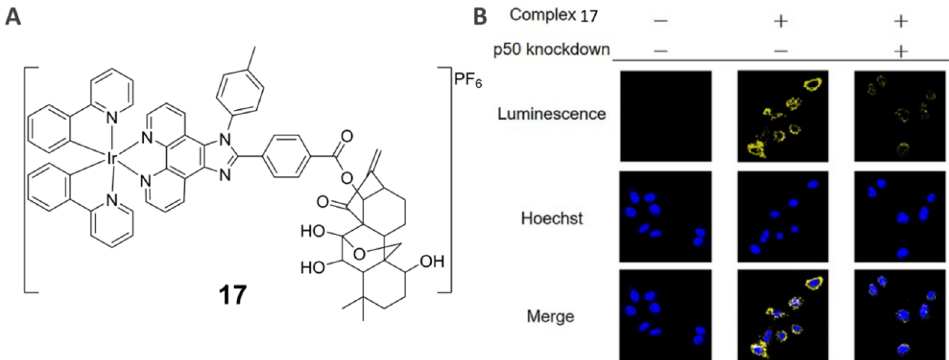
Figure 12. ( A ) Chemical structure of complex 17 . ( B ) Effects of p50 knockdown on the tracking of NF-κB in HeLa cells. Normal HeLa cells and p50 knockdown HeLa cells were treated with or without 17 (10 μM) for 4 h followed by stimulation with TNF-α (25 ng/mL) for 20 min. The yellow color indicates the luminescence from complex 17 , while the blue color indicates the fluorescence from Hoechst 33342 in the nucleus. Reproduced with permission from ref. [87]. Copyright 2017 John Wiley and